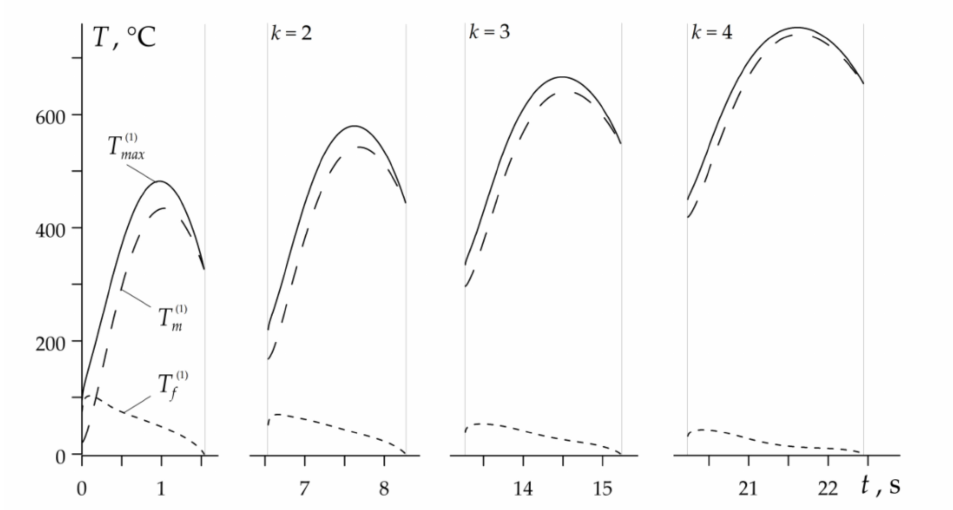
( k ) max (solid lines), the mean T